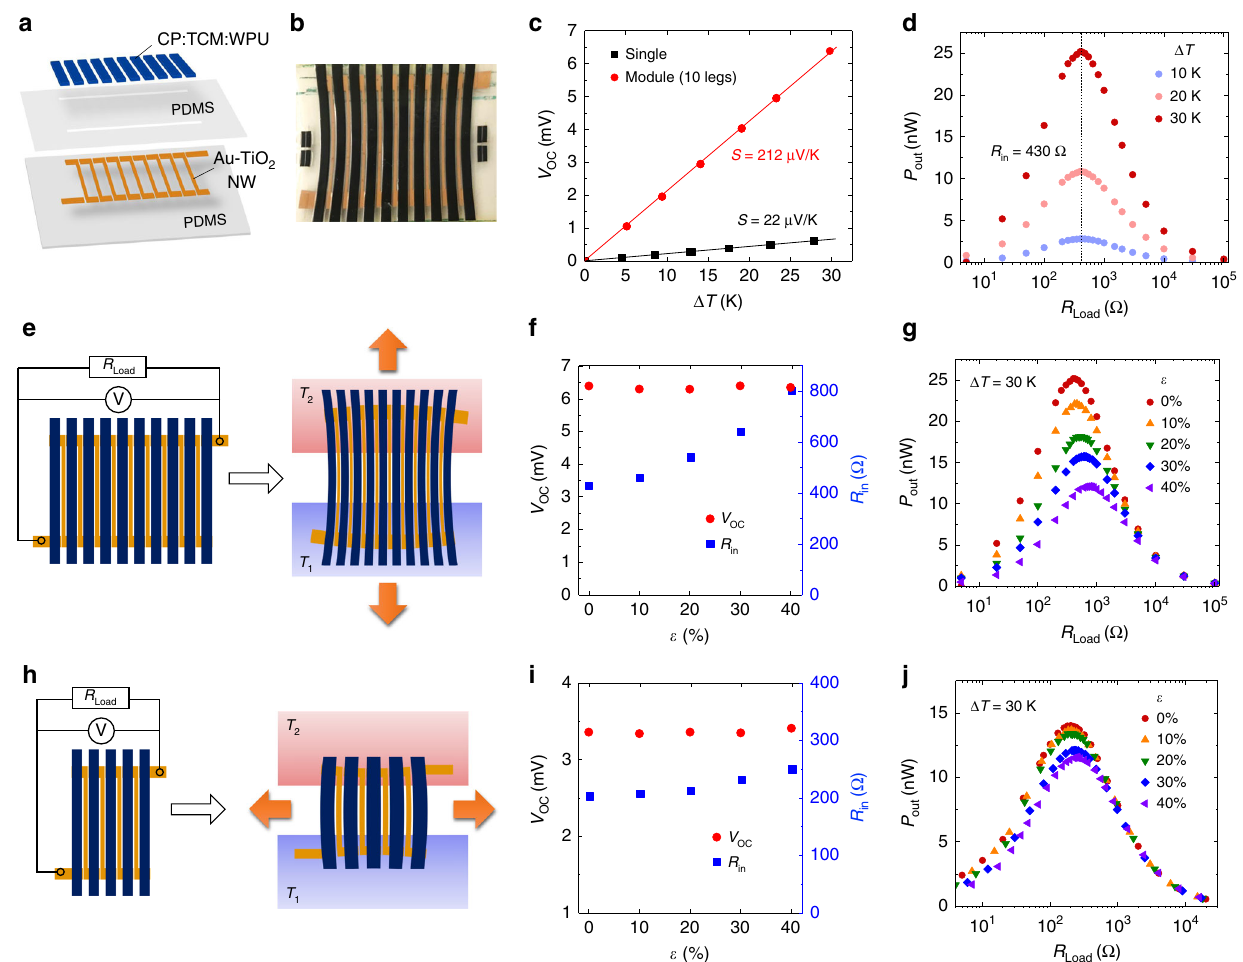
Fig. 6 Intrinsically stretchable organic thermoelectric module. a An architecture of the stretchable thermoelectric (TE) module. One end of each TE leg (CP:TCM:WPU = 15:25:85, w/w) is electrically interconnected with the other end of a neighboring leg through a z-shape stretchable interconnect (Au- TiO 2 nanowires). b Photograph of a stretchable TE module under 30% tensile strain. c Open-circuit voltage ( V OC ) of a single leg TE device and a 10-leg TE module as a function of temperature difference ( Δ T ). d Output power ( P out = V out 2 / R load ) of a TE module as a function of load resistance ( R load ) for Δ T = 10 − 30 K. The dashed line indicates an R load value that gives the maximum P out , and thereby corresponds to the total internal resistance ( R in ) of a module. e – g TE module stretched parallel with the thermodiffusion. T 1 = 23 °C, T 2 = 53 °C. f V OC and R in vs. tensile strain ( ε ) applied to a module for Δ T = 30 K. g P out vs. R load under different strains for Δ T = 30 K. h – j TE module stretched perpendicular to the thermodiffusion and corresponding V OC and R in vs. ε and P R Δ T = 30 out vs. load under different strains for